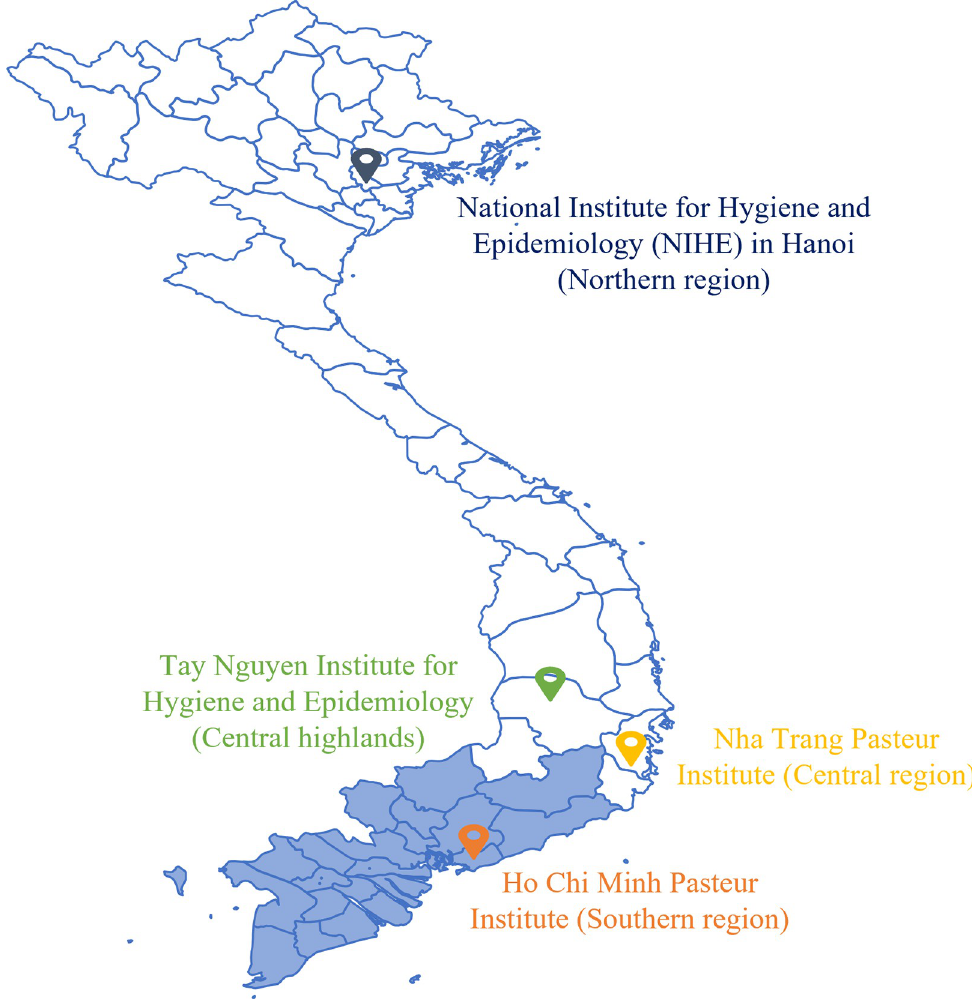
Fig 1. Study area– 19 provinces of southern